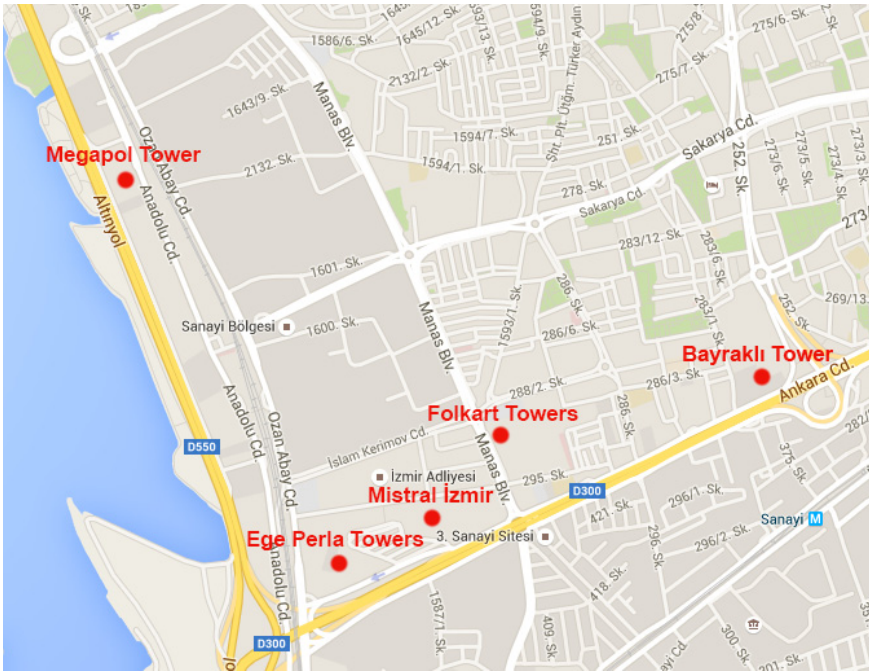
Figure 6. Partial Map of Bayrakl ı showing the high-rises